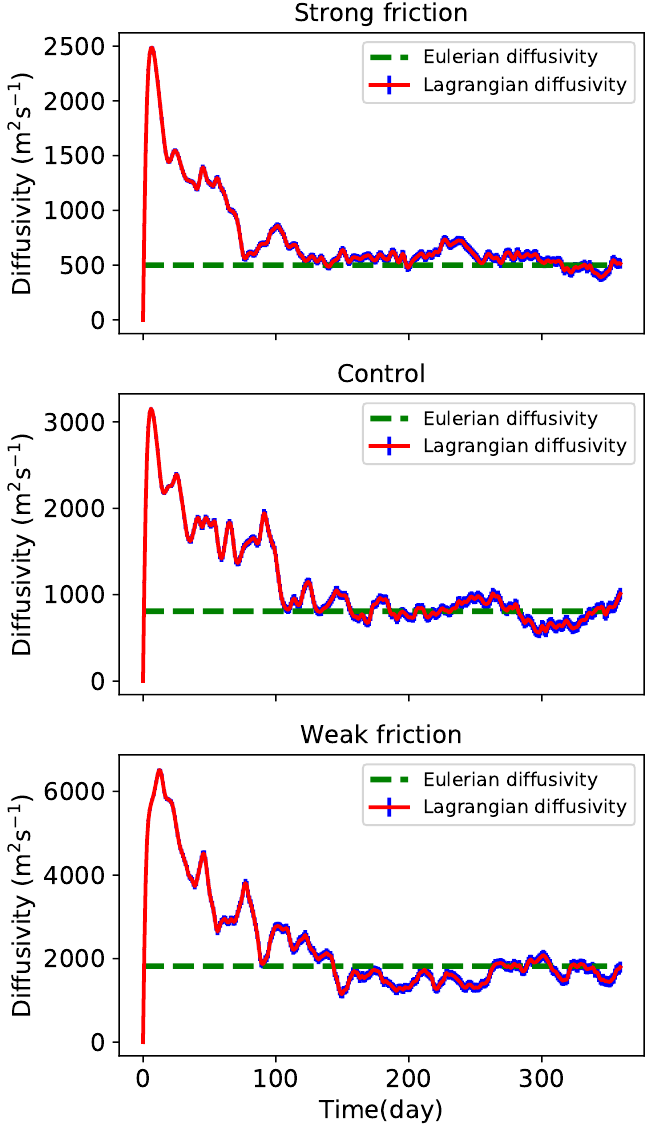
Figure 15. Upper level Lagrangian diffusivity calculated by (8) (red curve) with shaded error bars of 2 times standard error, and Eulerian diffusivity (green dashed